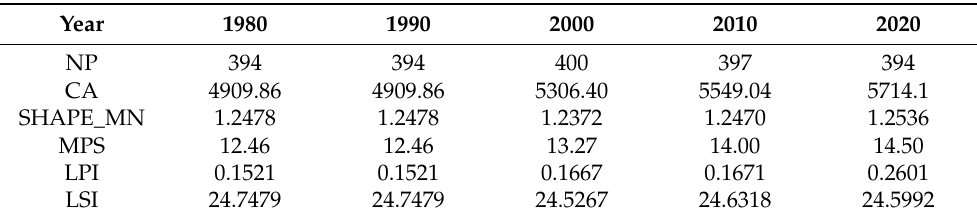
Figure 5. Evolution of the nuclear density of rural settlements in the Chaohu Peninsula. Table 4. Changes in the landscape pattern index of rural residential areas from 1980 to